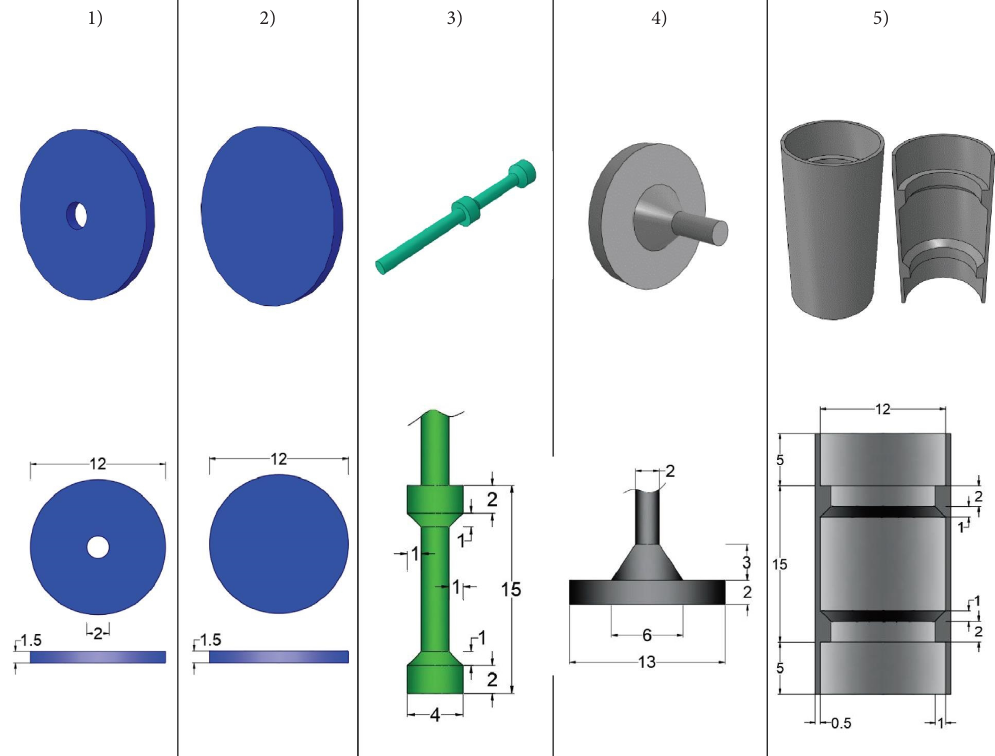
Figure 9: Te elements of intelligent recommended damper (dimensions in cm).